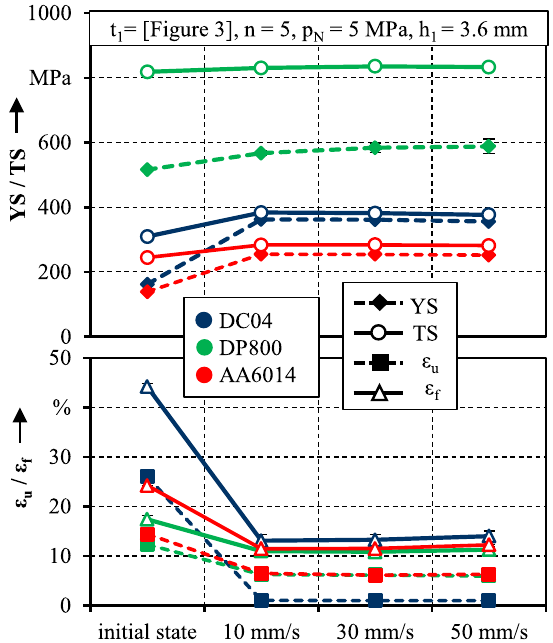
Fig. 6. Tensile test parameters after a drawbead with variation of the drawing velocity between v = 10mm/s and 50mm/s ( h 1 =3.6 mm, p N =5 MPa).